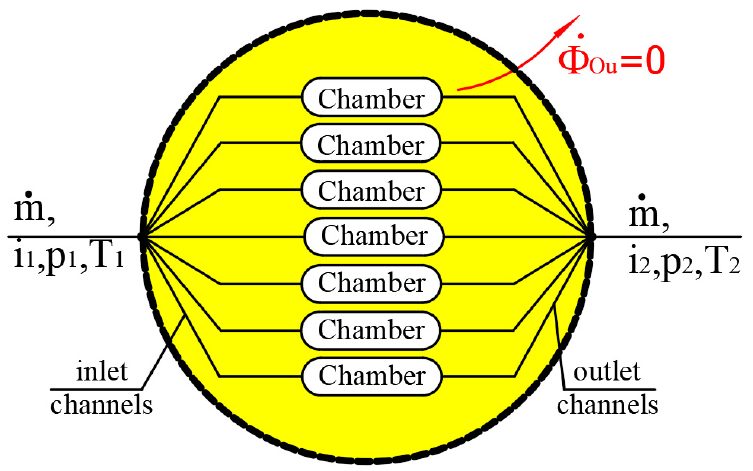
Figure 6. Parameters of the working liquid at the inlet and the outlet of an unloaded hydraulic motor (enthalpy equality occurs i 1 = i 2 ).